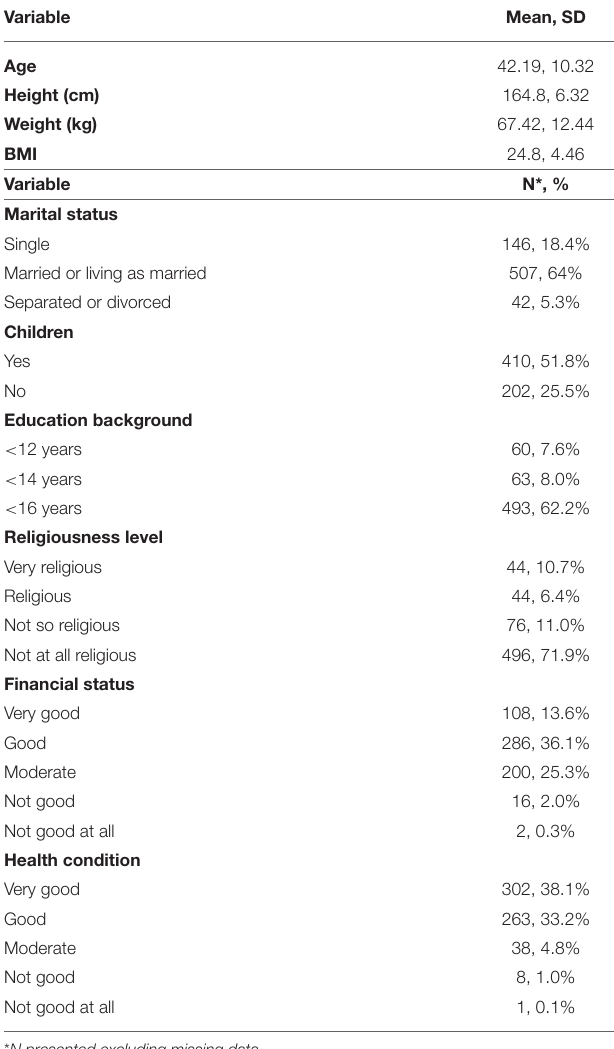
TABLE 1 | Basic information of the sample ( N =